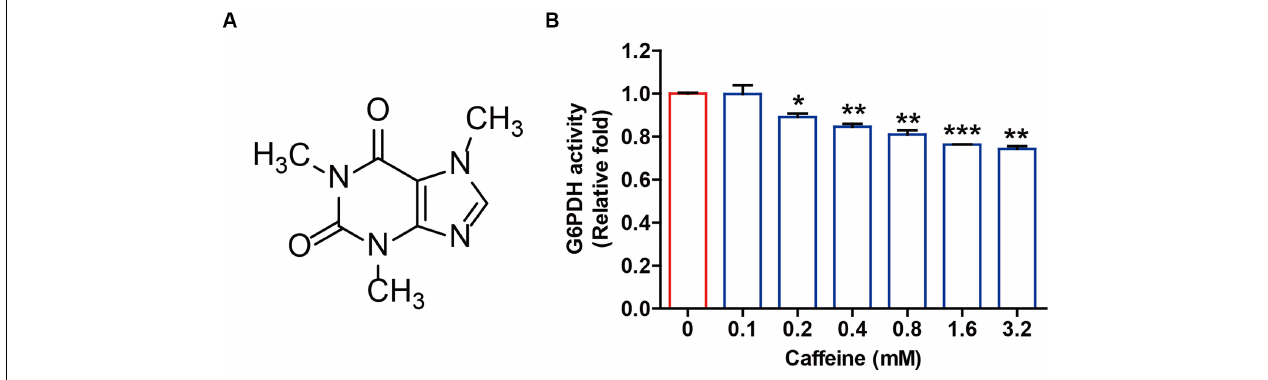
FIGURE 1 | Caffeine directly inhibits G6PDH activity in a pure enzyme reaction system. (A) The chemical structure of caffeine. (B) Caffeine inhibits G6PDH activity in an in vitro system. The effect of caffeine on G6PDH enzymatic activity was determined using a G6PDH Activity Colorimetric Assay Kit. * P < 0.05, ** P < 0.01, and *** P < 0.001 versus the control group. Data are shown as means ± SEM of triplicated